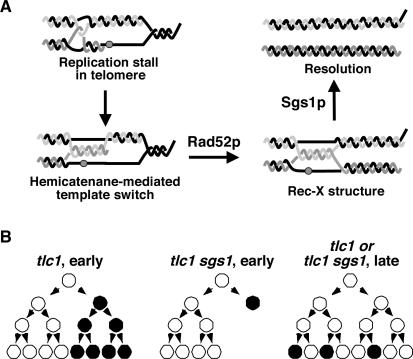
Models for Sgs1p Function during Senescence(A) A stalled replication fork in telomere DNA (barrier represented by an oval) is rescued by HC-mediated template switching, RAD52-dependent rec-X formation, completion of DNA replication, and then SGS1-dependent resolution. The template switching step is thought to be RAD52 independent because no strand invasion occurs. Branch migration of rec-X structures in a centromeric direction would generate the molecules observed in the spike region of two-dimensional gels. Sgs1p would cooperate with its Top3p cofactor to enable strand transfers during rec-X resolution; in the absence of Sgs1p, telomeres would remain linked by the HC created by template switching and rec-X formation.(B) Completed telomere recombination (filled circles) early in the lineage of a senescing tlc1 cell (at a long telomere) gives rise to progeny bearing the recombinant telomere (left). Stalled recombination in a tlc1 sgs1 cell leading to arrest would not generate progeny (middle). Whether completed or not, recombination at the end of senescence (at a short telomere) does not give rise to progeny (right).